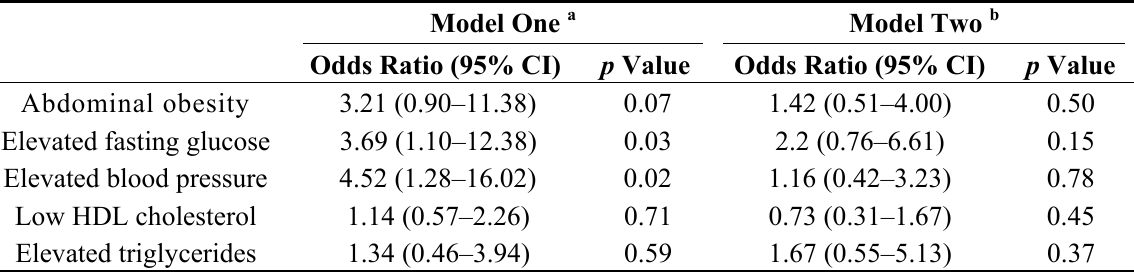
Table 4 . Associations between MetS components and CKD in Group